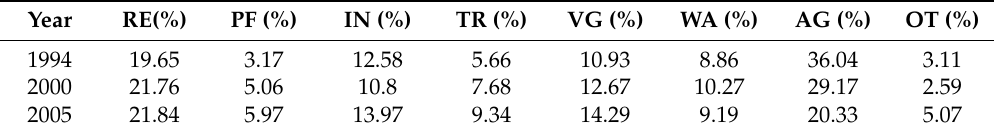
Table 1. Percentages of LCLU types in 2.5-m spatial resolution classification map.